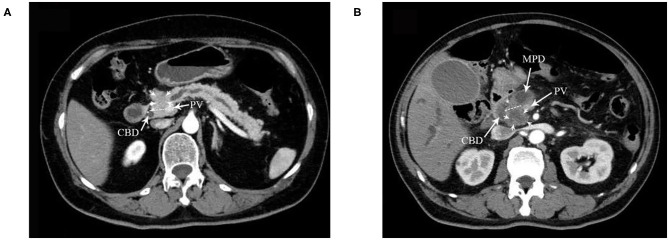
A dotted line on the CT image indicates the boundary between the ventral and dorsal head of the pancreas in (A,B). (A) DE group: tumor located in the dorsal head of the pancreas. CBD, common bile duct. PV portal vein. Arrows indicate the tumor. (B) VE and VS groups: tumor located in the ventral head of the pancreas. MPD, mean pancreatic duct. Arrows indicate the tumor.